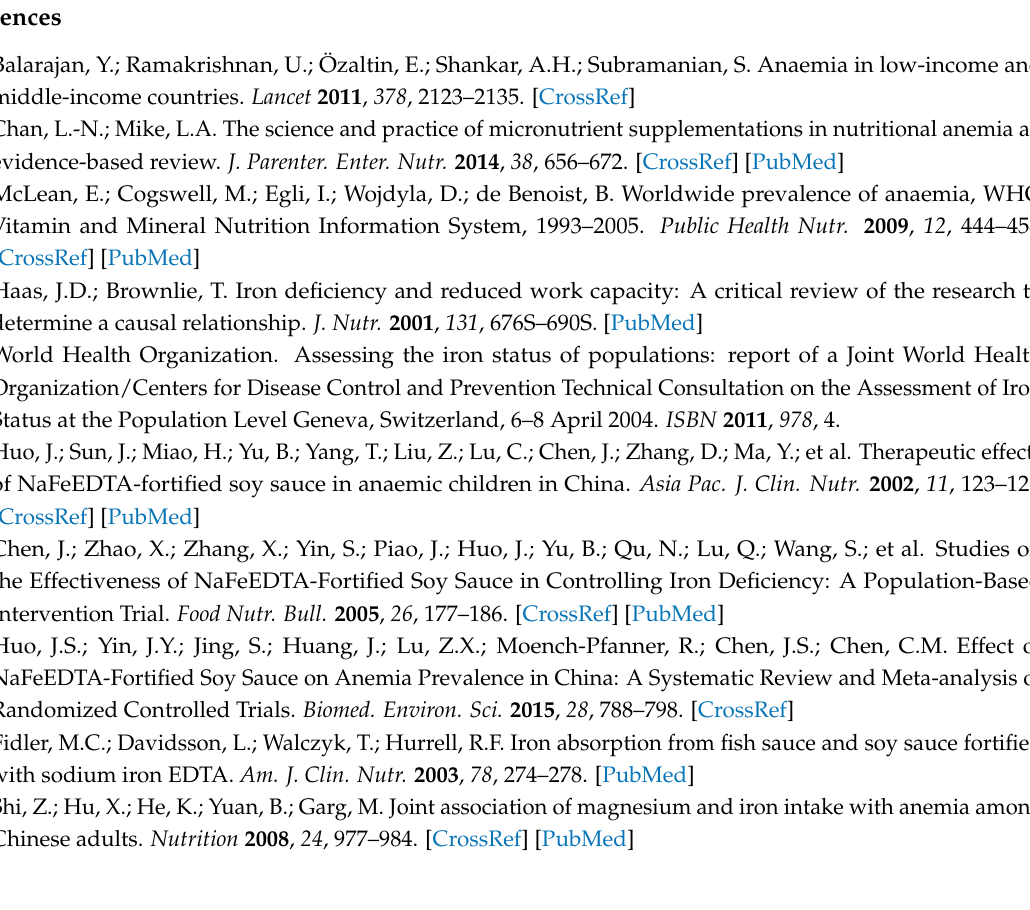
Table S1: Comparison of baseline characteristics between women with and without anemia at baseline; Table S2: Comparison of baseline characteristics between men with and without anemia at baseline; Table S3: Sex-stratified comparison of baseline characteristics (mean ± standard deviation for numerical traits, percentages for binary traits) by merging the separate results for age-matched women and age-matched man with and without anemia at baseline; Table S4: Comparison of baseline characteristics between women with and without incident anemia at follow-up; Table S5: Comparison of baseline characteristics between men with and without incident anemia at follow-up; Table S6: Sex-stratified comparison of baseline characteristics (mean ± standard deviation for numerical traits, percentages for binary traits) by merging the separate results for age-matched women and age-matched man with and without incident anemia at follow-up; Table S7: Sex-stratified correlation coefficients of baseline measures; Table S8: Comparison between the four subgroups for five-year incident anemia at follow-up and the evaluation set; Figure S1: Correlation structure of the baseline subset. The nodes represent variables and the edge width indicates the strength of the correlation (thicker means stronger). Only topologically important edges are depicted: the strongest pair-wise correlations within a module are included, whereas the edges between any two modules are collapsed into a single grey line in the